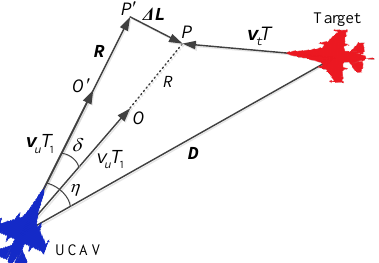
Figure 4. Schematic diagram of the aiming geometry of the UCAV in the attack guidance state in